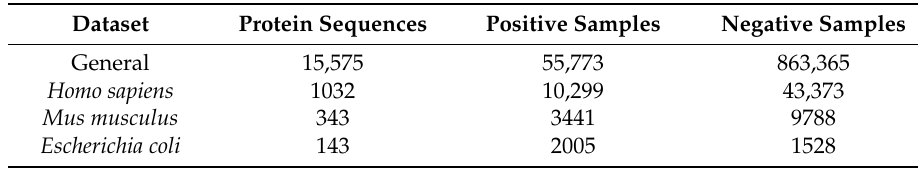
Table 9. Detailed information of employed datasets.